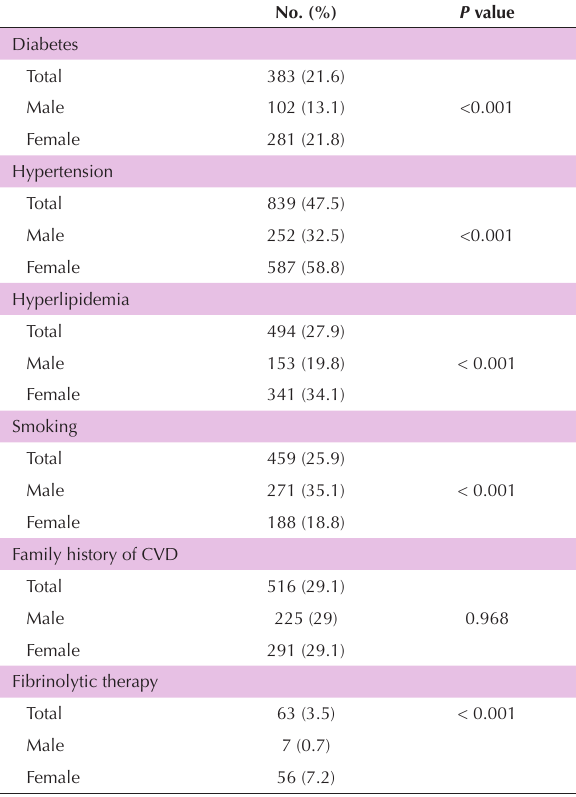
Table 2. Past medical history, smoking status, family history and fibrinolytic therapy status of patients with MINOCA No. (%)